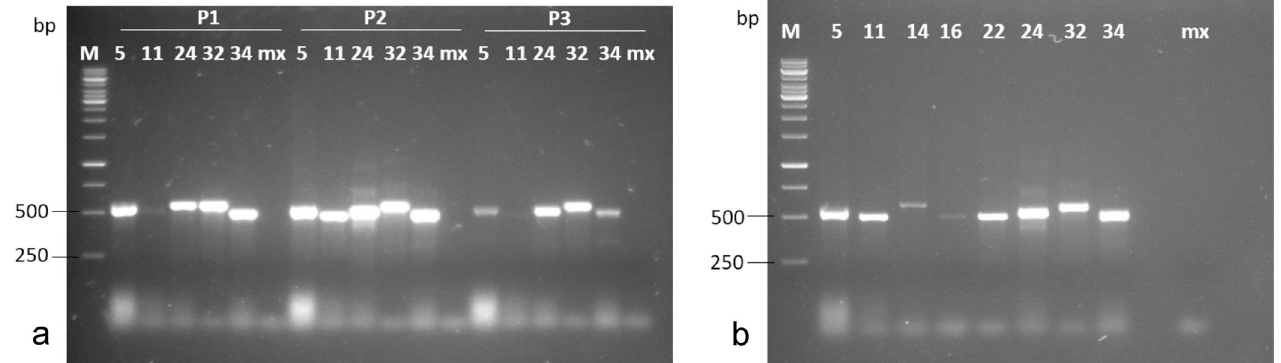
Fig 4. PCR amplification of ITS gene from 8 isolates causing yam anthracnose. a) PCR analysis using the three sets of primers. b) PCR analysis using primer set 2. 5,11,14, 16, 22 are isolates from D . alata . 24, 32 and 34 isolates D . rotundata . M, 1 kb DNA ladder, mx, DNA master mix.